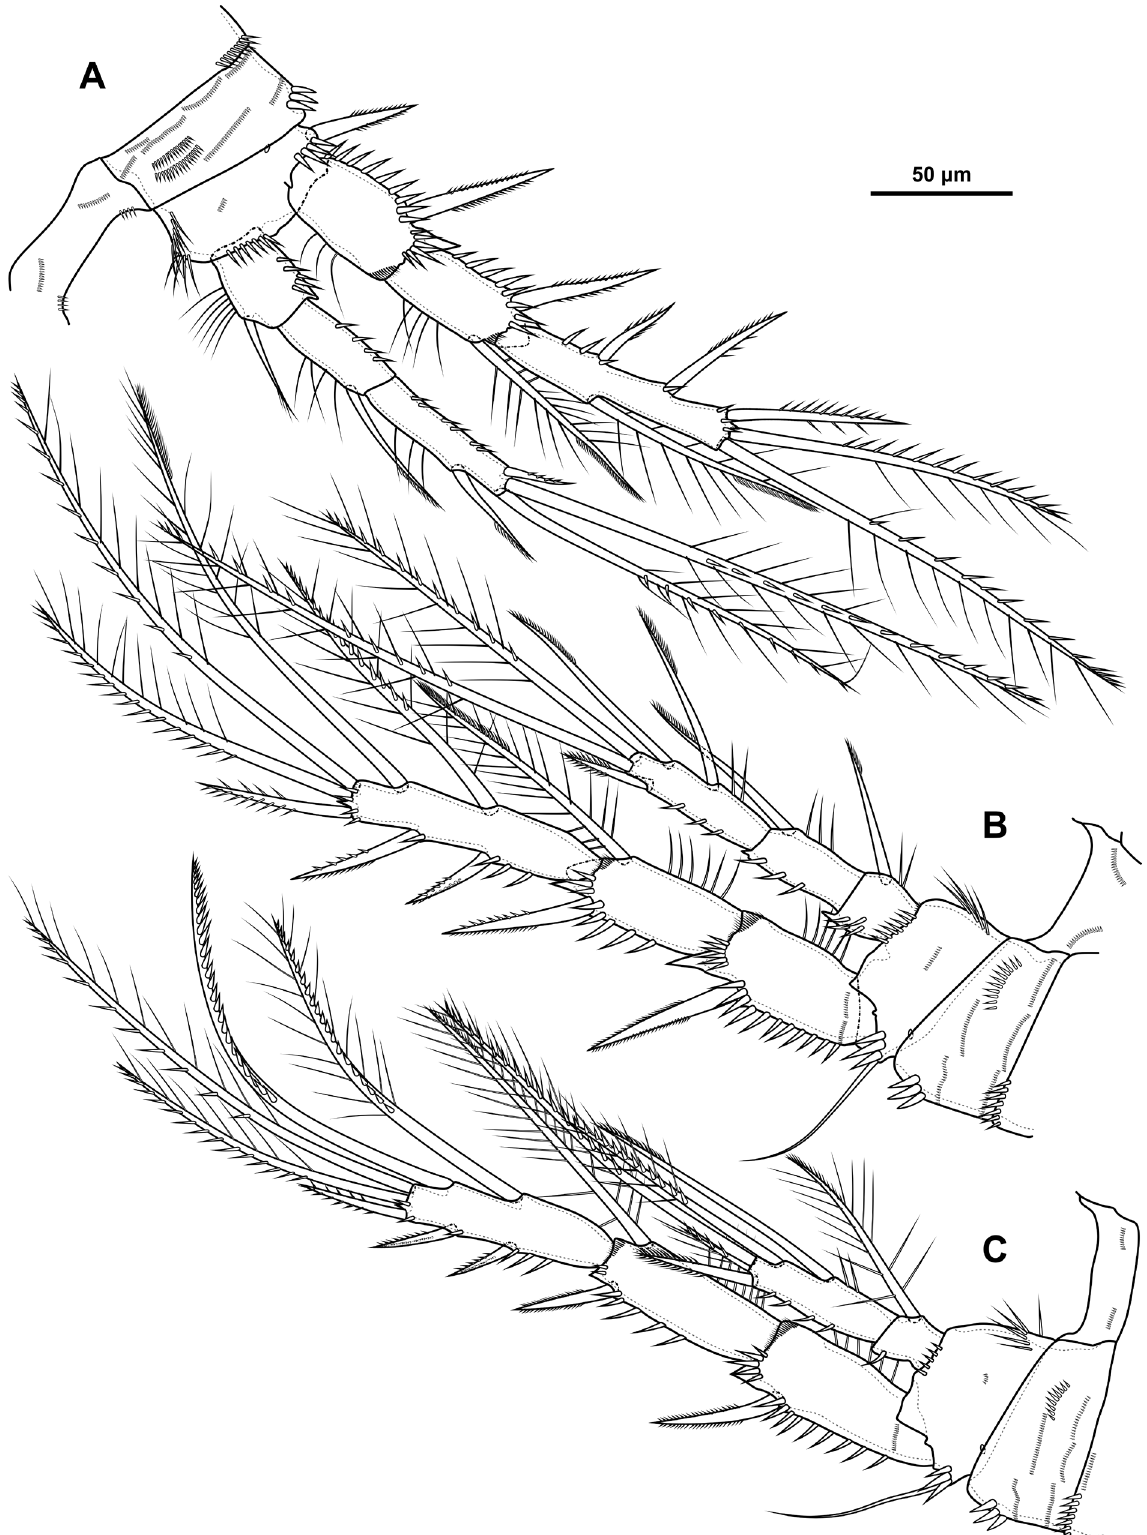
Fig. 6. Canthocamptus waldemarschneideri sp. nov., holotype, ♀ (KFU BP 544/1). A . P2. B . P3. C .